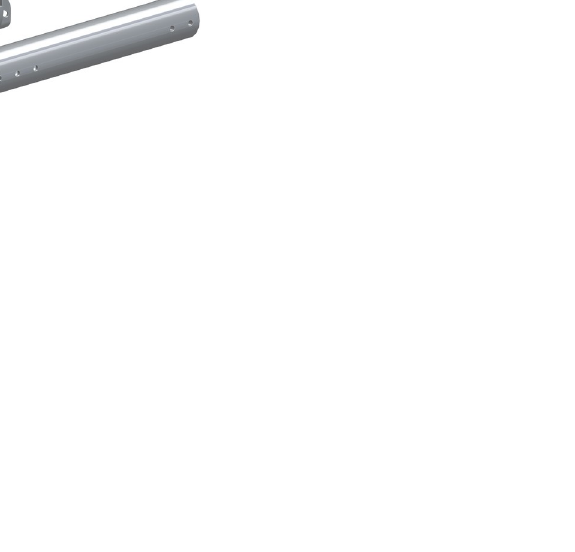
Fig 26. Addition of Foot-Rest to leg assembly.